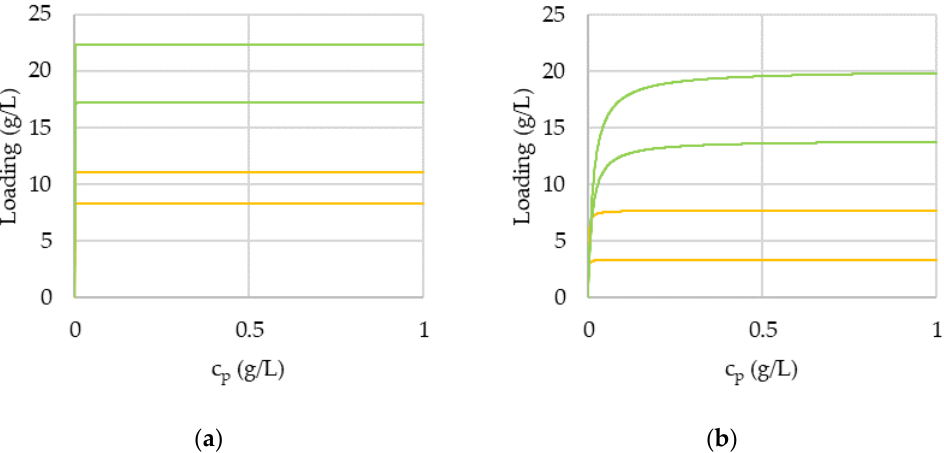
Figure 2. Enveloping isotherm curves of HCP1 (yellow curves) and HCP2 (green curves) with the parameters from Tables 2 and 3: ( a ) at 0.05 mol/L salt concentration and ( b ) 0.6 mol/L salt concentration. Table 2. HCP1 parameter boundaries for the dataset generation.